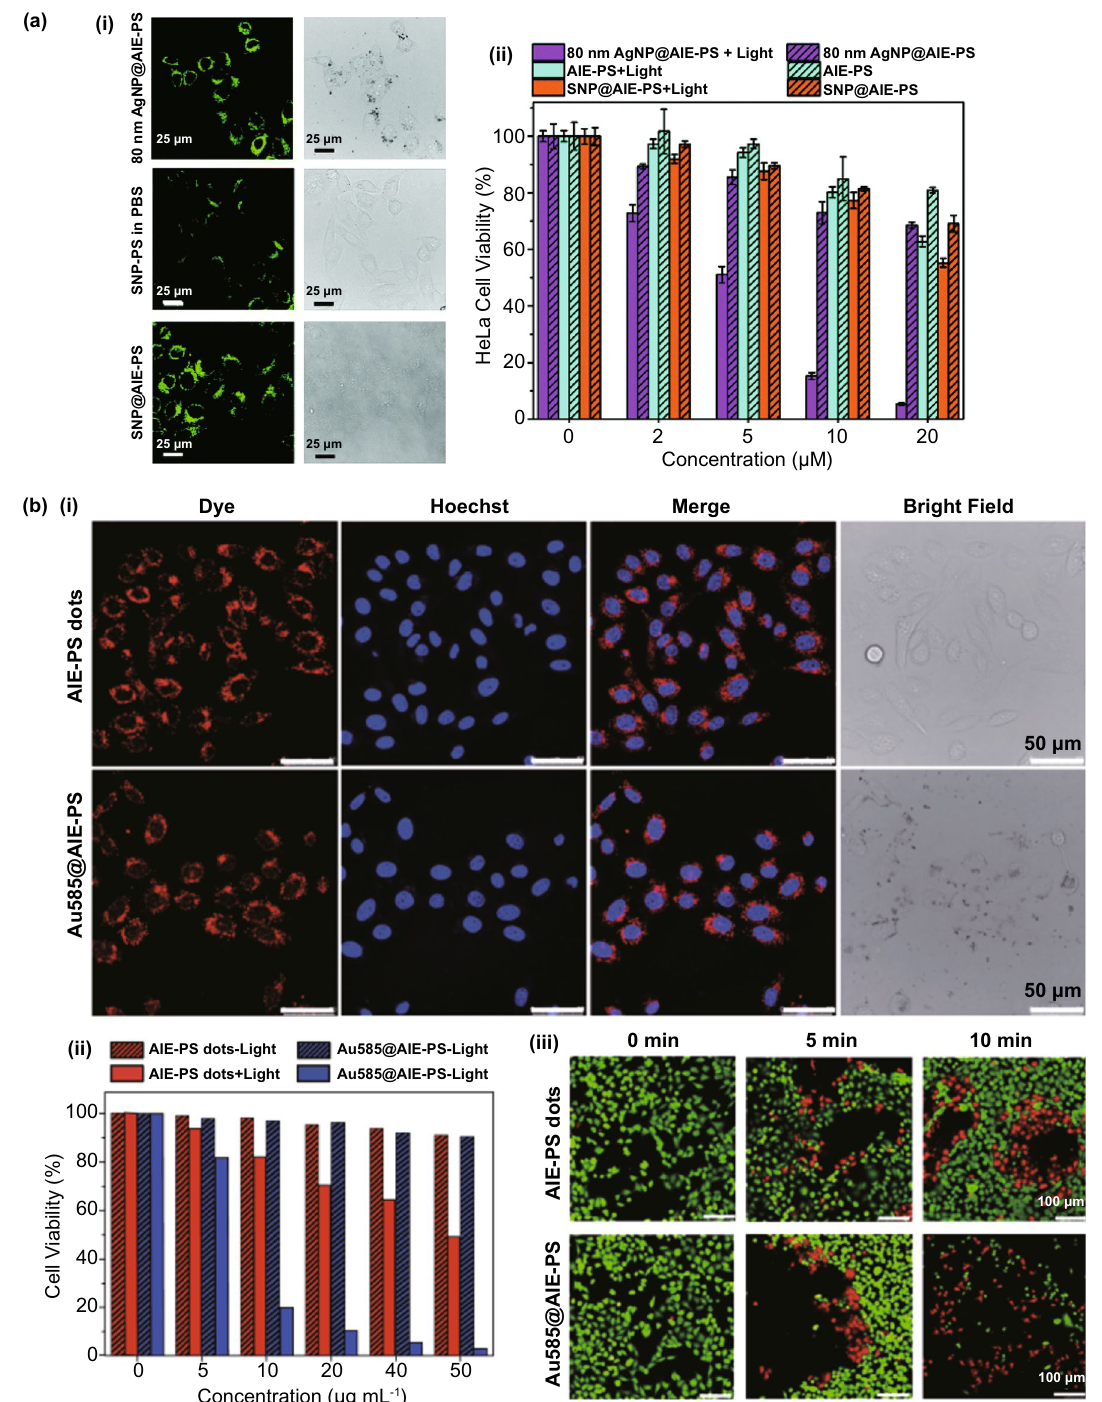
Fig. 13 a (i) Confocal fluorescence imaging and bright field images of HeLa cells incubated with 80 nm AgNP@AIE-PS (top row) and AIE-PS dots (bottom row) in physiological buffer solution (PBS), respectively. Silica nanoparticles (SNP) @AIE-PS is used as the control samples, (ii) cytotoxicity of the same samples in a under white light illumination and at darkness against HeLa cells, reproduced from Ref. [22] with permis- sion from Royal Society of Chemistry, b (i) Confocal fluorescence imaging and bright field images of HeLa cells incubated with AIE-Ps dots and Au585@AIE-PS dots samples. The nuclei were stained with Hoechst dye., (ii) Cell viability of HeLa cells after incubation with different concentrations of AIE-PS and Au585@AIE-PS samples with and without white light illumination. (iii) Live/dead cell staining of HeLa cells before (0 min) and after light treatment for 5 and 10 min, respectively, reproduced from Ref. [21] with permission from